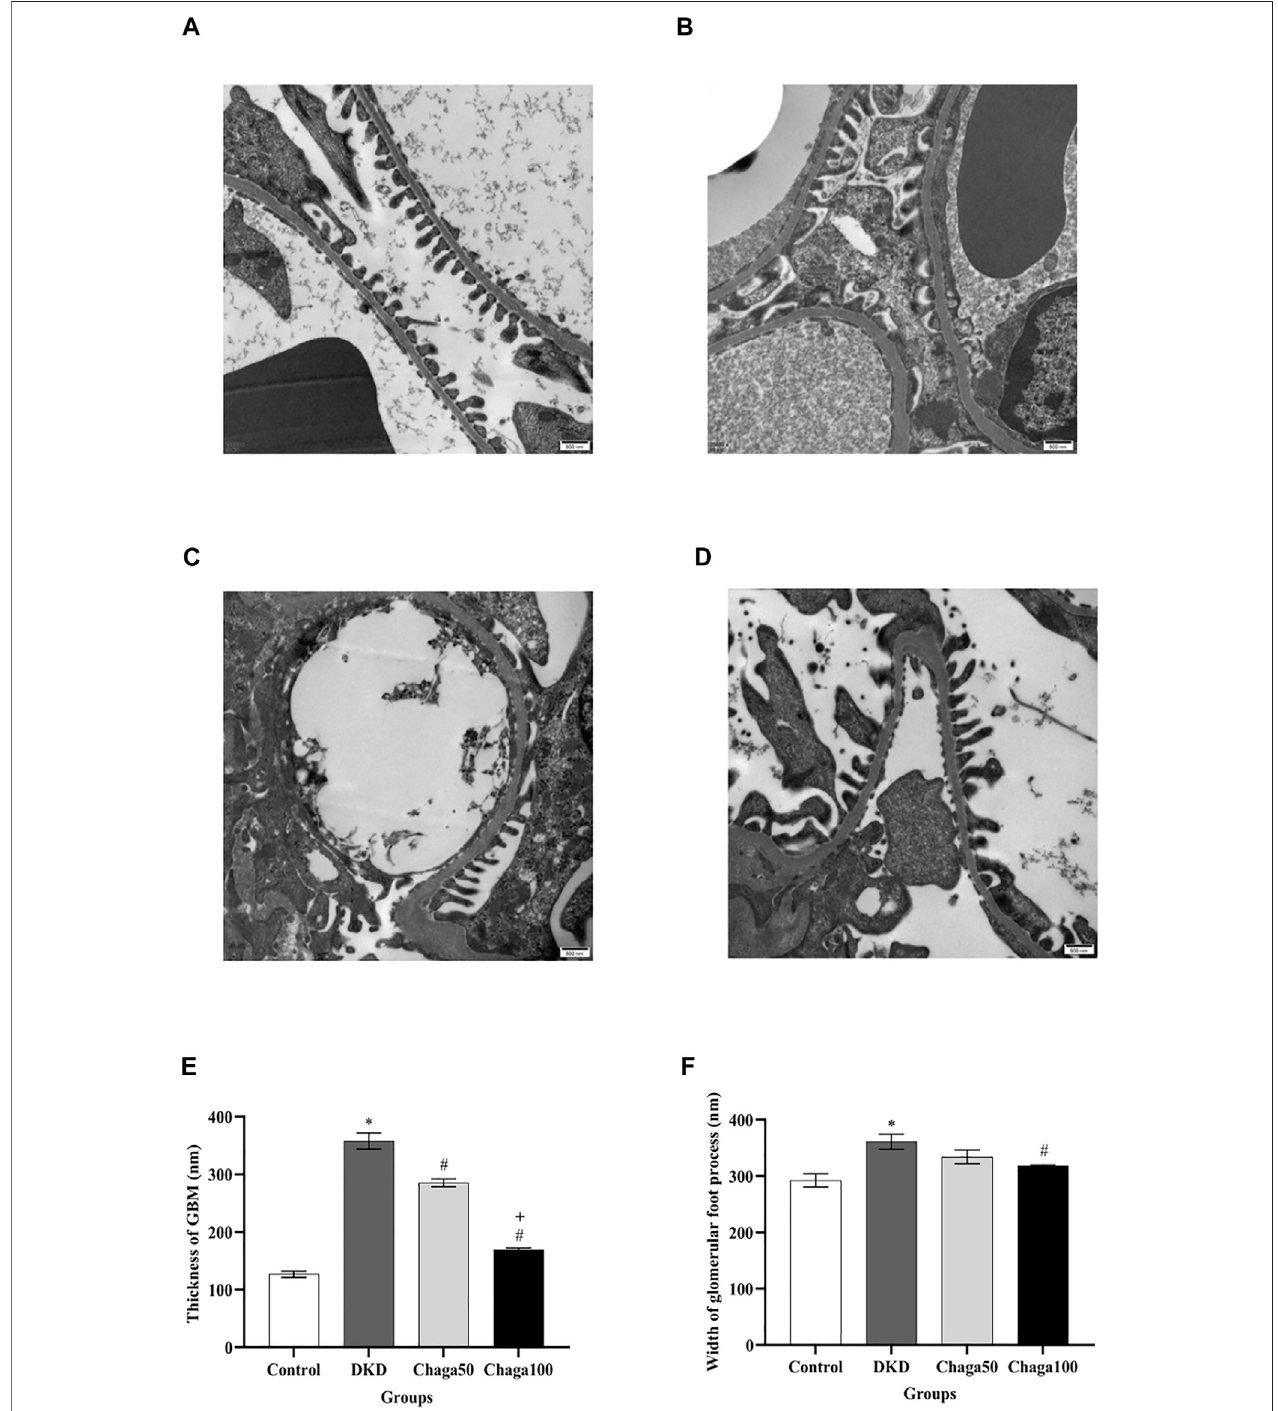
FIGURE6| EffectsofchagaonthepathologicalparametersofDKDratmodelundertheelectronmicroscope. (A – D) Electronmicroscopicimagesofthebasement membrane of the glomerulus and foot processes of podocytes ( × 20,000). (A) Normal control group. (B) DKD model group. (C) Chaga50 group. (D) Chaga100 group. (E) Thickness of GBM of rats in each group. (F) Foot process width of rats in each group. Data were presented as mean ± SE. DKD, diabetic kidney disease; Chaga50, treatment with 50 mg/kg of chaga group; Chaga100, treatment with 100 mg/kg of chaga group; GBM, glomerular basement membrane. * p < 0.05 vs. Normal control group, # p < 0.05 vs. DKD group, + p < 0.05 vs. Chaga50 group.